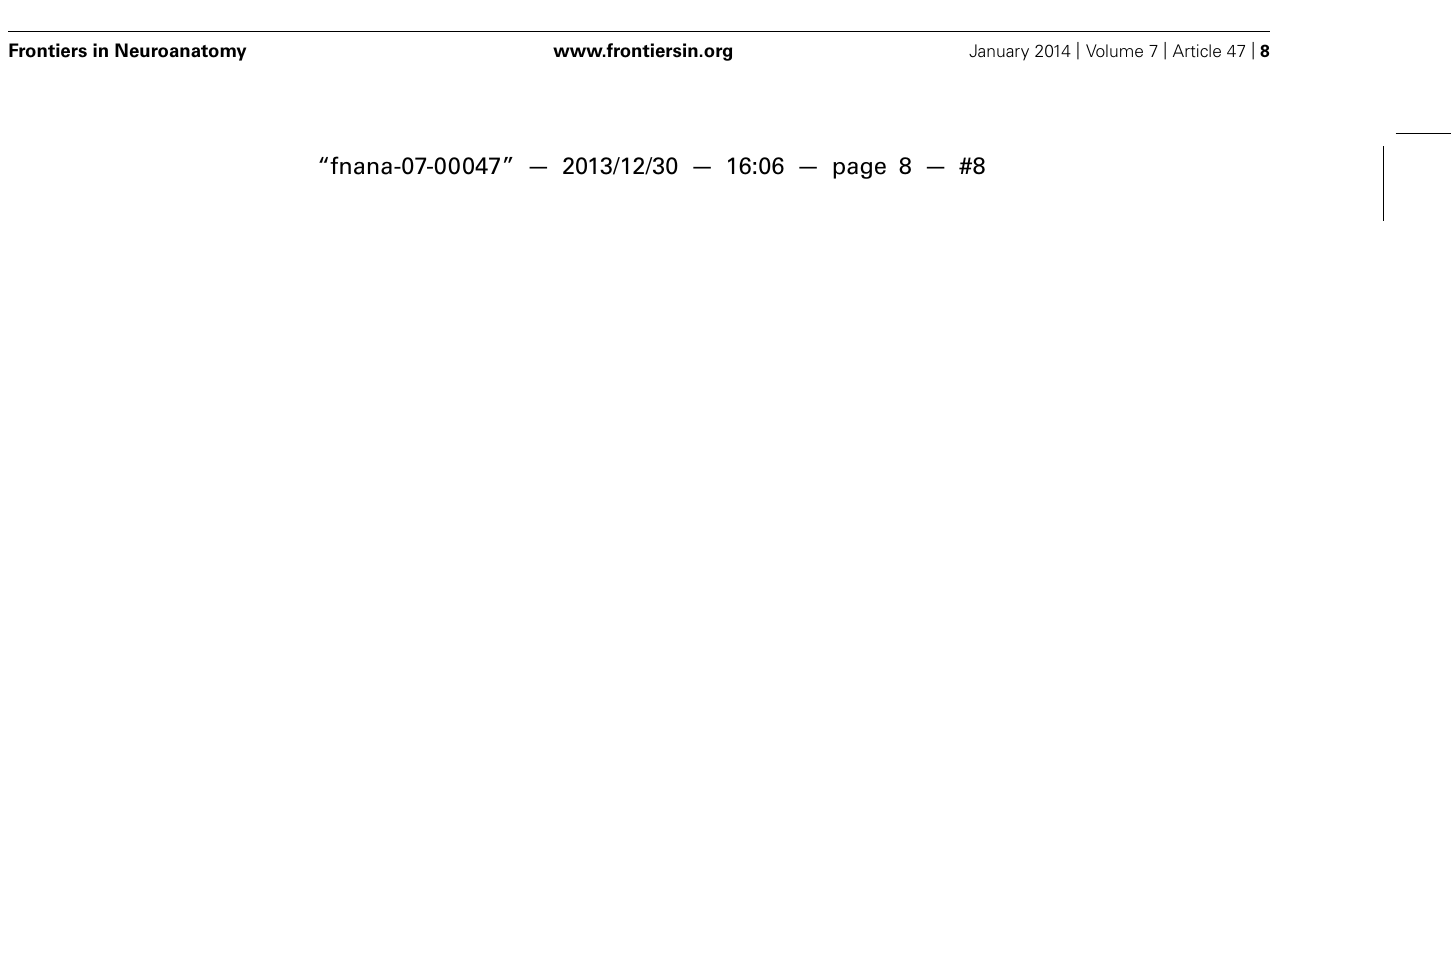
Figures 5A–C .The insets in (C) and (F) are expanded images in the white squares, showing traced callosal neurons. Electroporated cells are shown in red and GFP positive cells infected with RV in green. Slices were stained with DAPI (blue) to visualize brain structures. Scale bars = 500 or 100 μ m